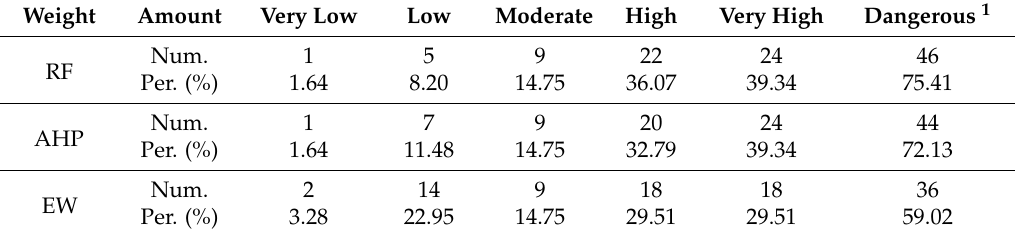
Table 5. Number of validation spots in different susceptibility areas based on different index